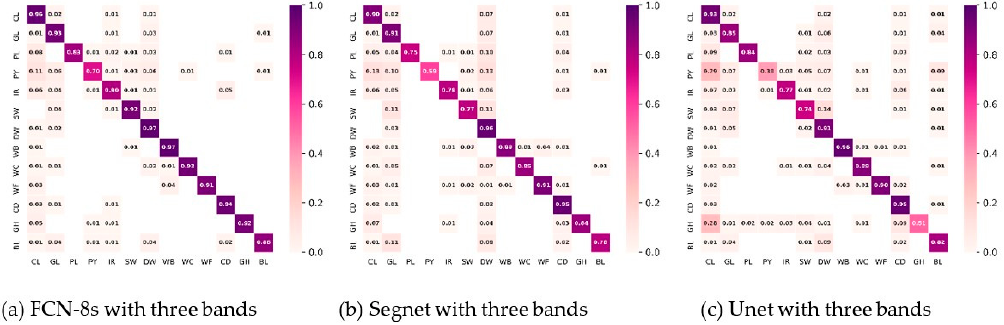
Figure 5. Heatmap visualization of the normalized confusion matrix (normalized per row) for land cover classification using three bands input with three models. ( a ) FCN-8s with three bands, ( b ) Segnet with three bands, and ( c ) Unet with three bands. The labeled values on each grid show the normalized accuracy of each class, which indicates the degree of confusion ratio with the other classes. The normalized accuracies greater than or equal to 0.01 are labeled. CL represents cereal land, GL represents grassland, PL represents poplar land, PY represents pathway in farmland, IR represents the impervious road, SW represents sparse woods, DW represents dense woods, WB represents water bodies, WC represents the waterless channel, WF represents water conservancy facilities, CD represents construction land, GH represents greenhouse, and BL represents bare land.